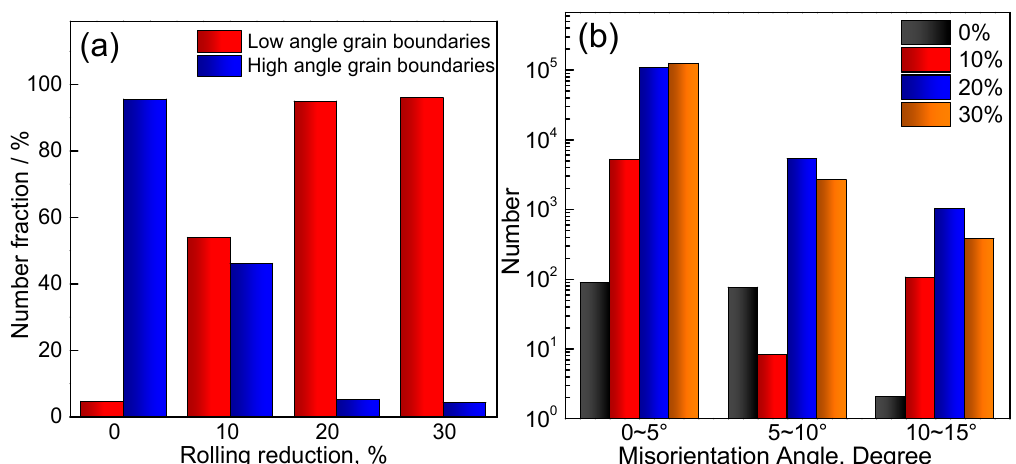
Figure 4. Grain boundary orientation statistics at different deformations: ( a ) distribution statistics of the grain boundary orientation difference under different deformations and ( b ) quantitative analysis of low grain boundaries at different angles.